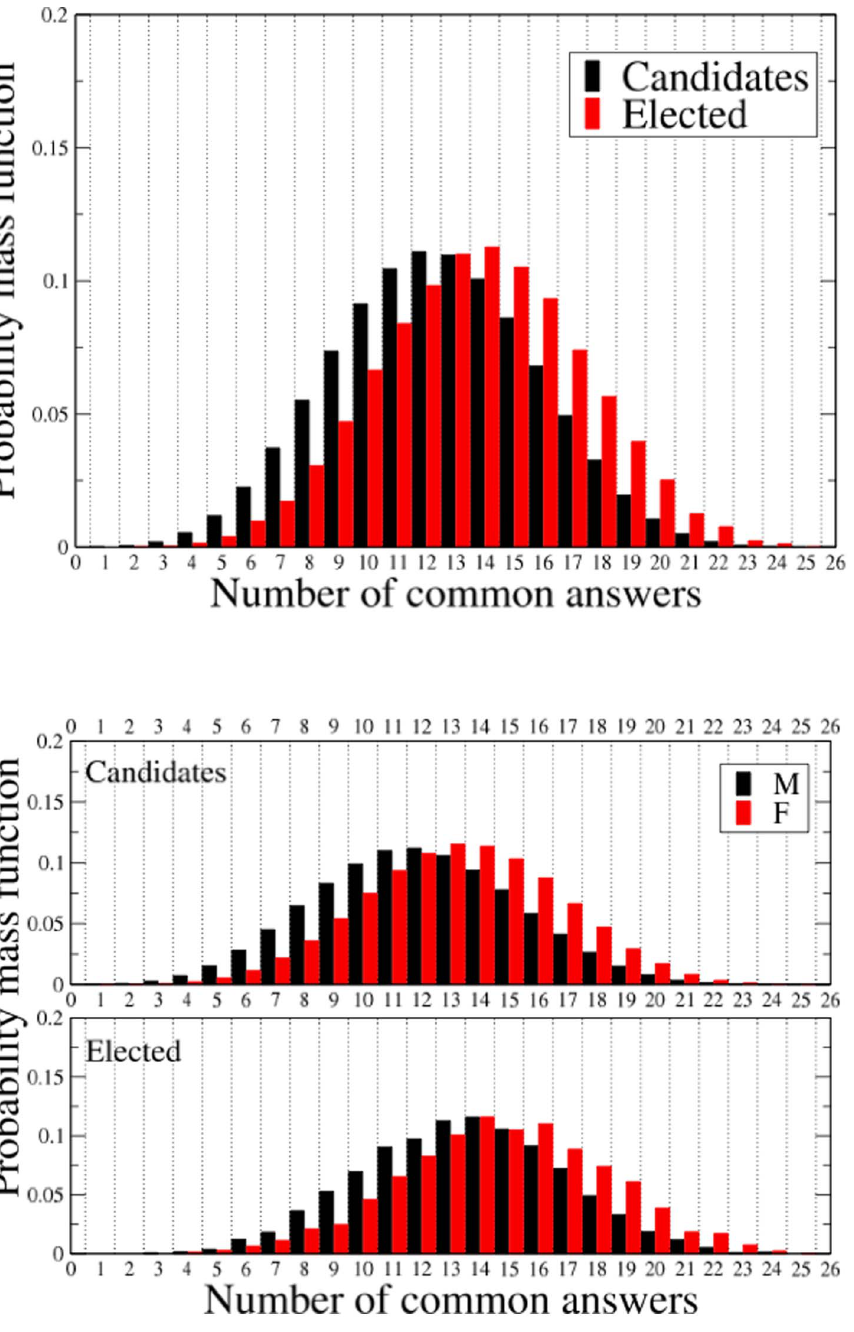
Figure 1. Probability mass functions of the number of common answers. Comparison between the probability mass function of the number of common answers between respondents, separately for candidates and elected (top panel) and disaggregated by gender (bottom panel). The probability mass functions are obtained by considering the answers of all 1,793 candidates who provided information about the gender, and the subset of 181 elected candidates.